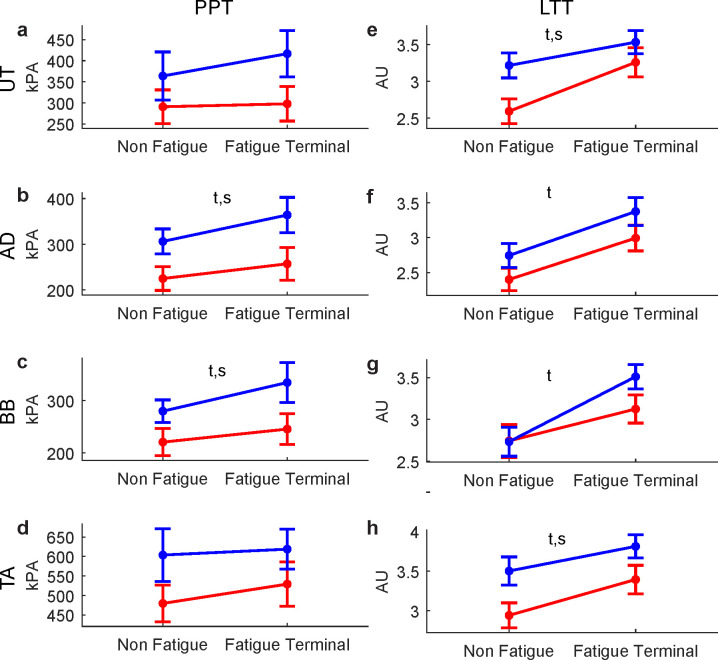
Effects of fatigue and sex on sensory variables.The left panels present the pressure point threshold (PPT) tested over the upper trapezius (UT, a), anterior deltoid (AD, b), biceps brachii (BB, c) and tibialis anterior (TA, d) muscles. The right panels present the light touch threshold (LTT) for the UT, AD, BB and TA. s: main effect of Sex, t: main effect of Time, s x t: interaction (not present). Women’s and men’s data are represented in red and blue, respectively.